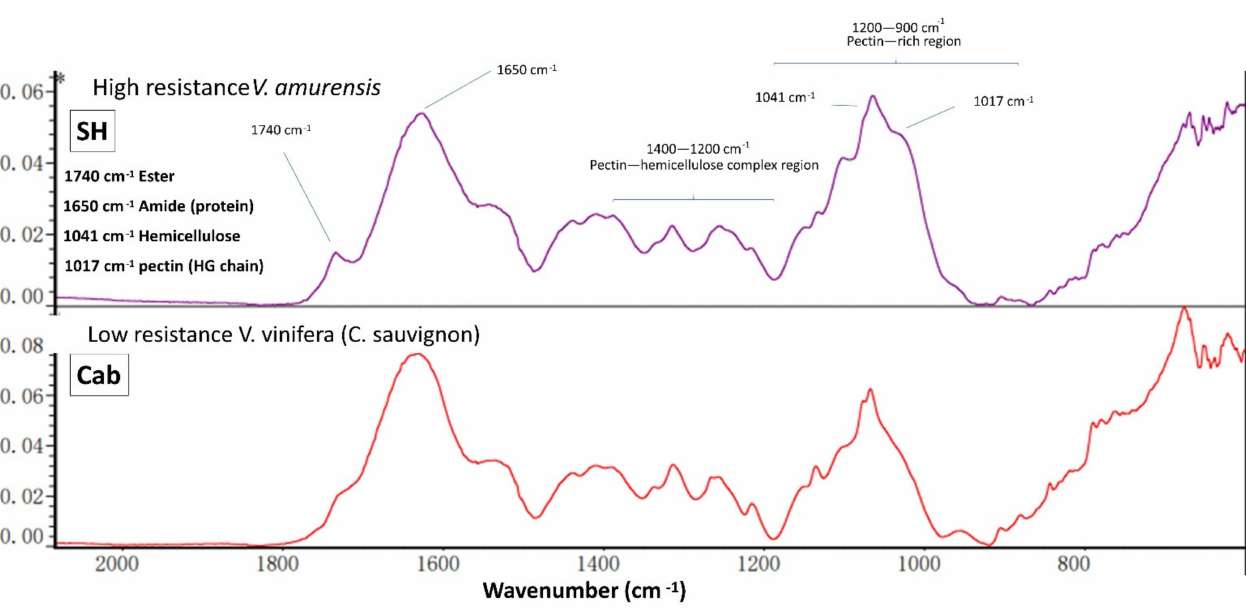
Figure 7. Fourier transform infrared (FT-IR) spectra generated from the AIR samples sourced from grapevine